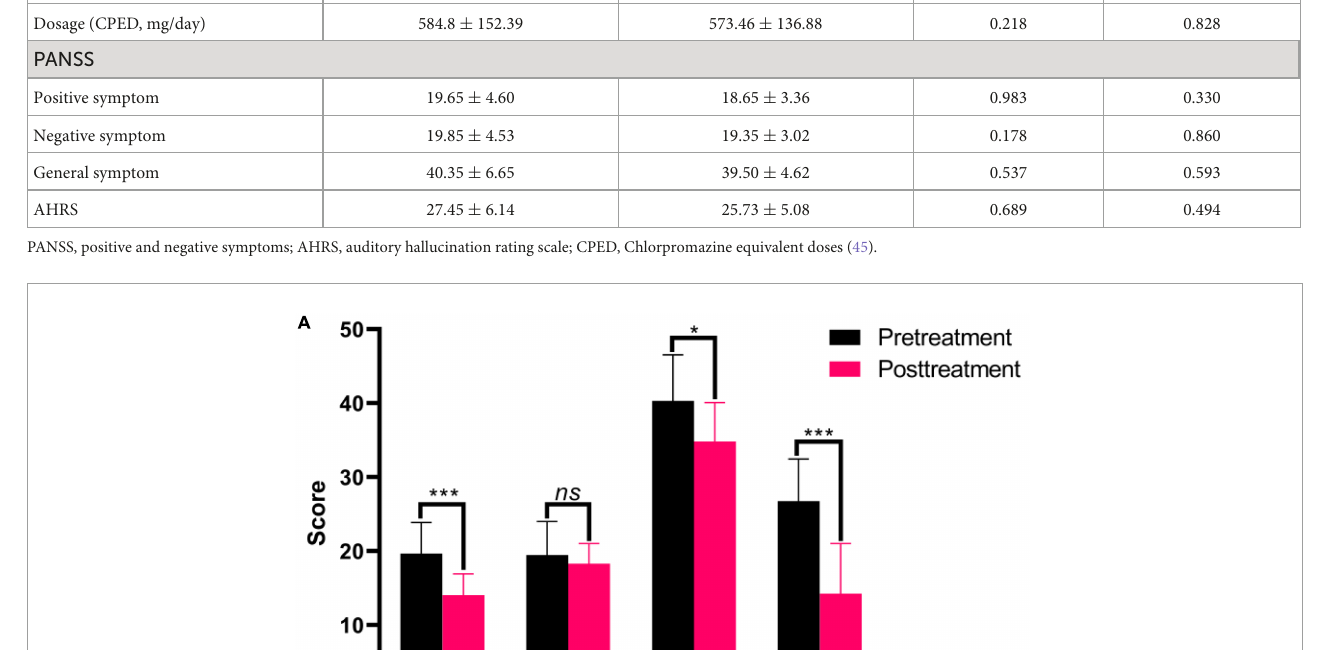
gyrus, right supplementary motor, and bilateral putamen, as well as decreased FC with the right inferior temporal gyrus and right middle temporal gyrus ( Figure 3A